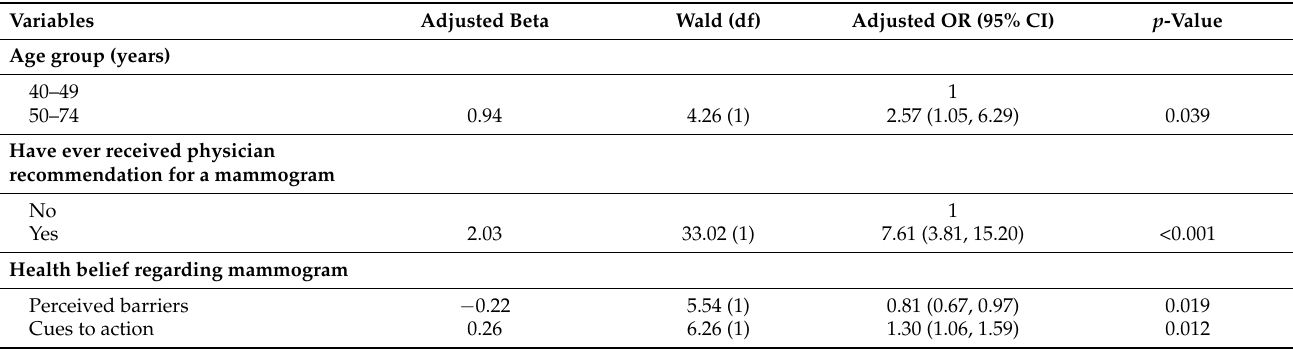
Table 5. Factors associated with screening mammogram